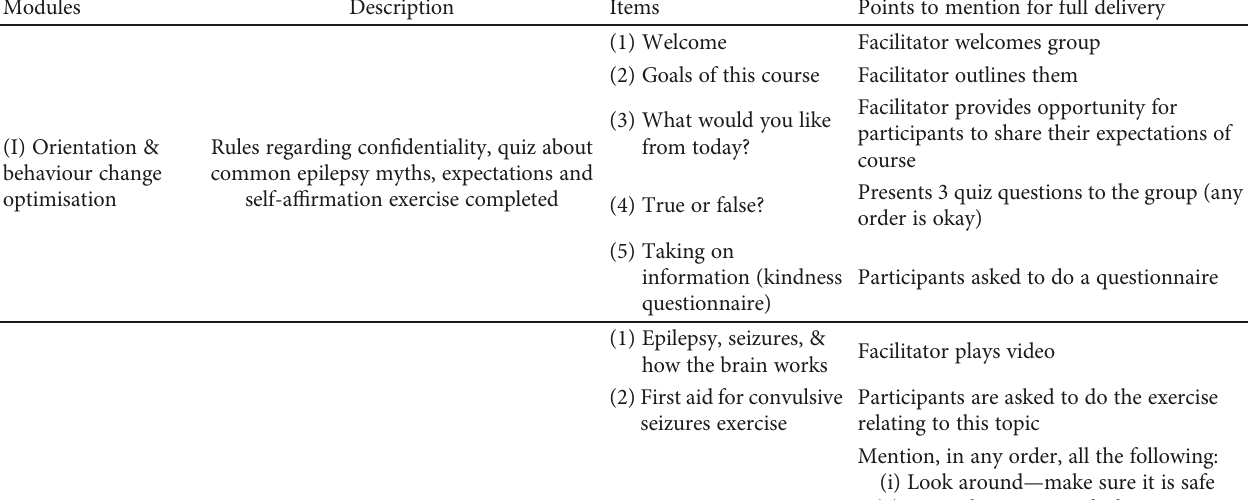
Table 1: Adherence items for